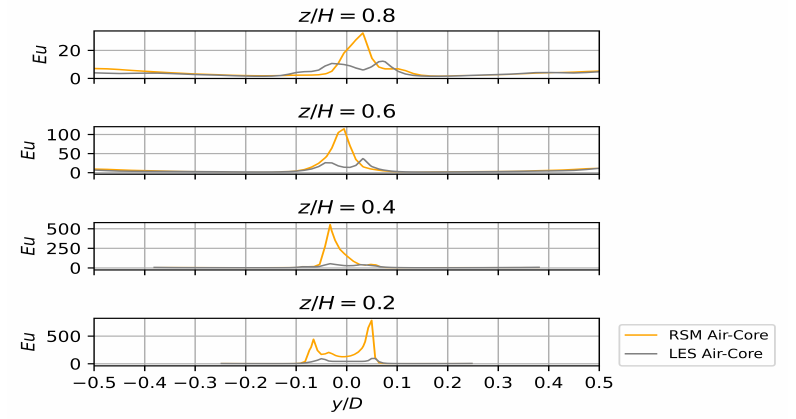
Figure 17. Euler number for the air-core models as a function of the normalised y co-ordinate at various heights at flow-time 2